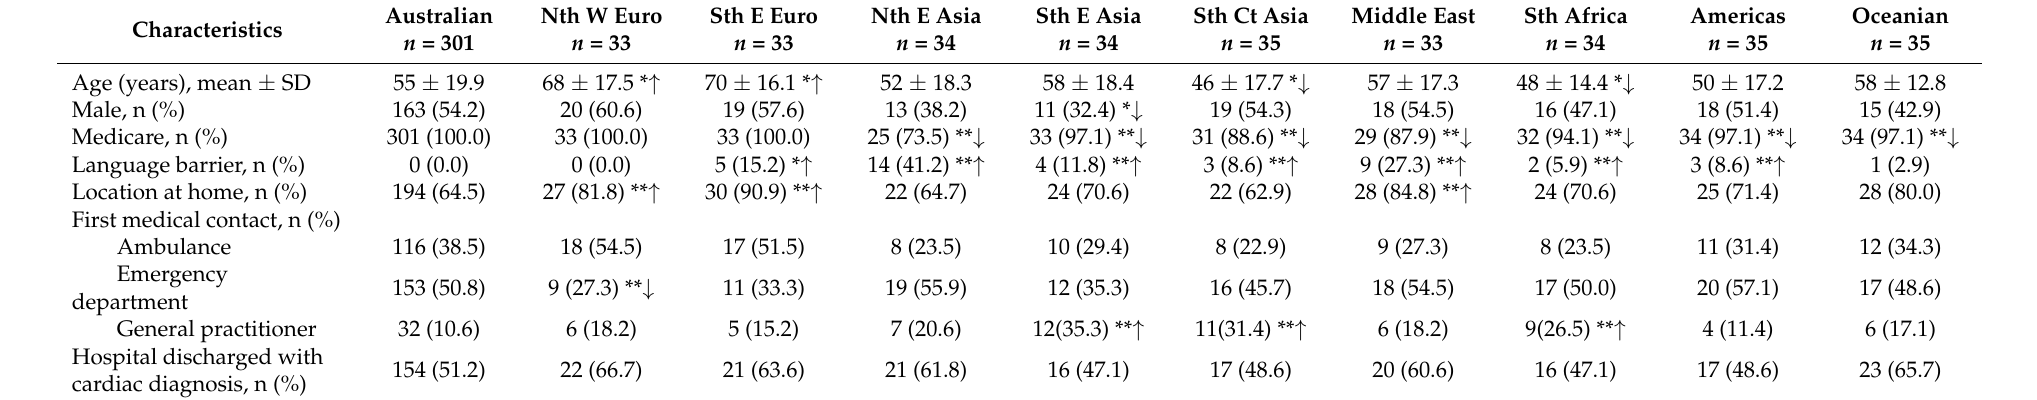
Table 2. Presenting characteristics of patients presenting to emergency department with chest pain by ethnic groups.